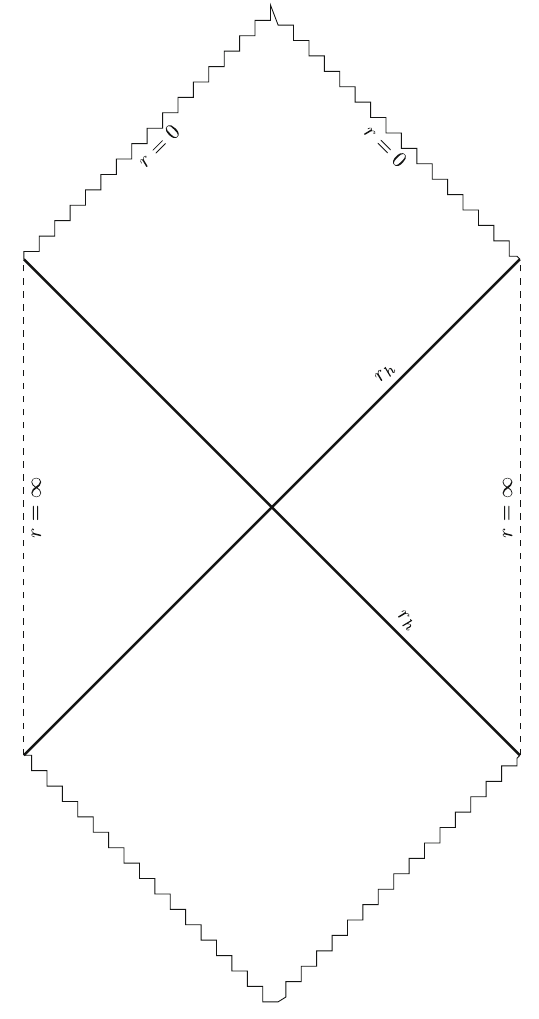
Fig. 7 Qualitative Carter–Penrose diagram of the geometry Eqs. (10, 24). The main regions along the holographic coordinate (boundary, horizon and singularity) are understood from Table 3. It is important to observe from the given characterization that, in general, we have a divided causal structure compatible with the black hole interpretation of the